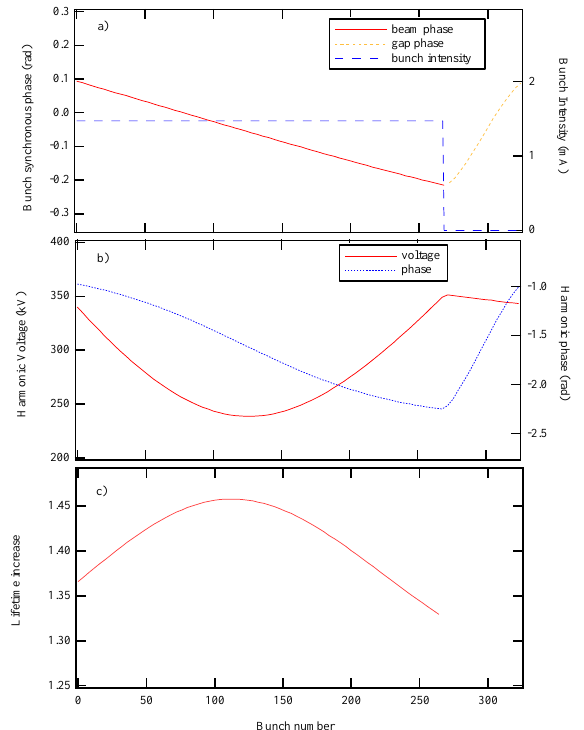
FIG. 6. (Color) Distribution of the bunch synchronous phase along the bunch train with a 17% gap showing strong transient effects. (a) Bunch synchronous phase (difference from nominal synchronous phase) and bunch intensity along the bunch train. (b) Harmonic voltage and phase. The optimal harmonic phase for bunch lengthening is about 2 1.5 rad. (c) Resulting length- ening increase which peaks near the middle of the bunch